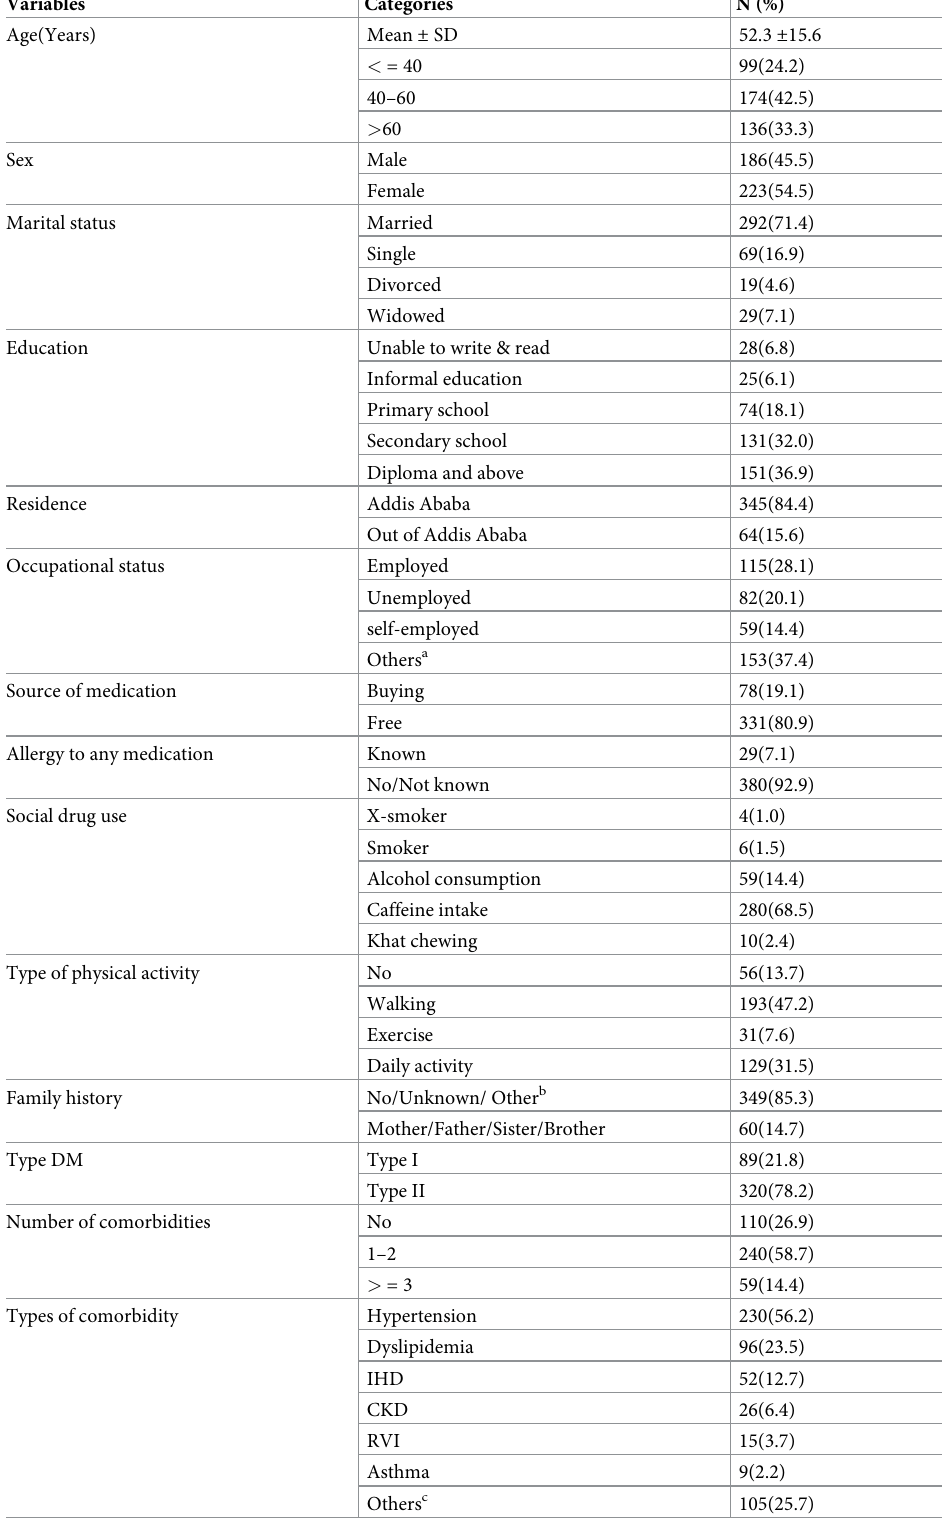
Table 1. Socio-demographic and clinical characteristics of adult